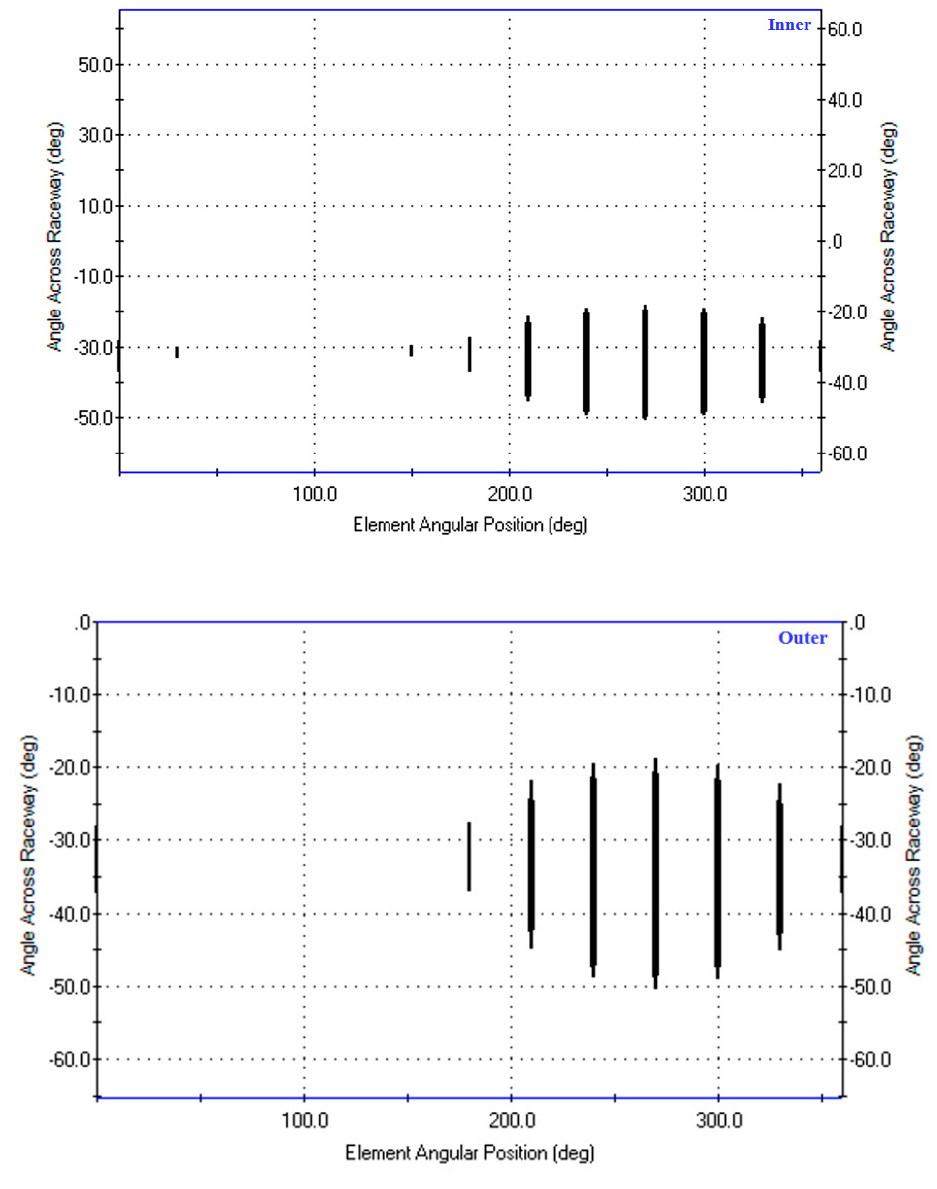
Figure 13. Contact footprint between balls and raceways. ( a ) Inner / Outer raceway of row 1 ( b ) Inner / Outer raceway of row 2.